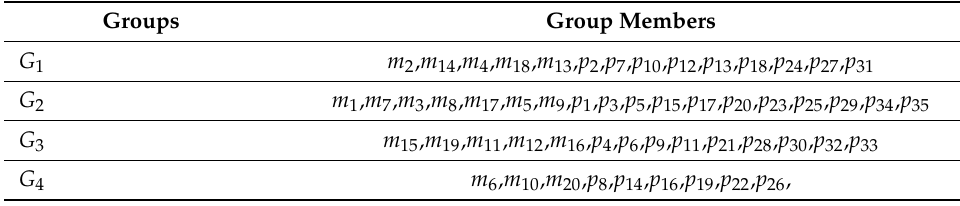
Table 7. The four groups in example 3.